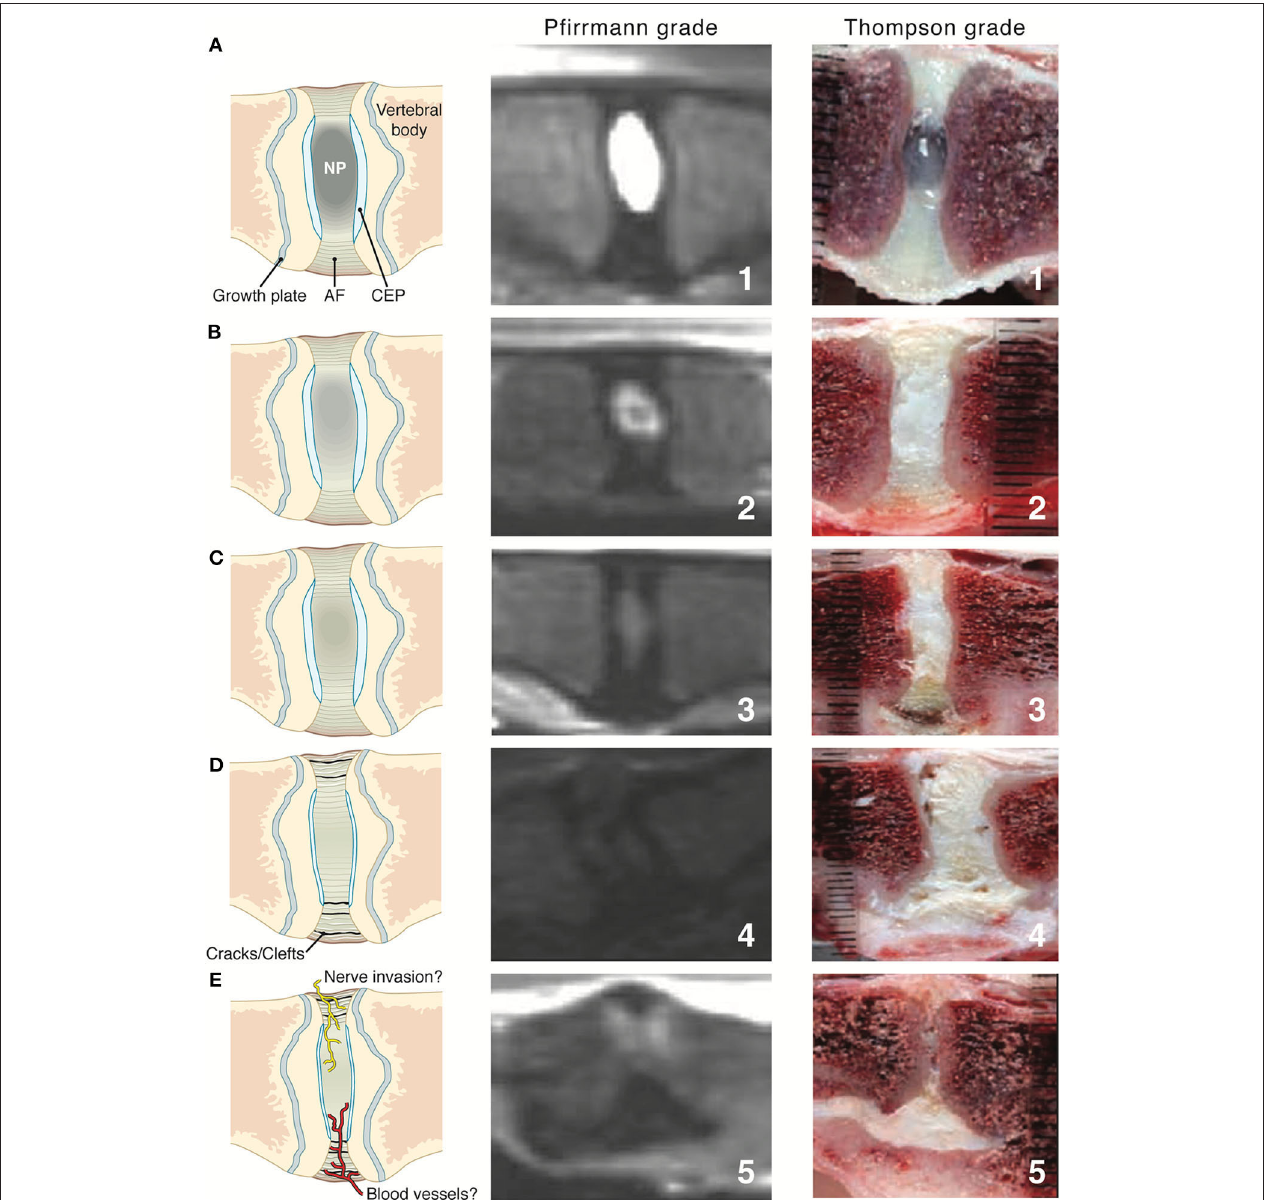
FIGURE 5 | Intervertebral disc (IVD) maturation from young to early and late stage IVDD where the first column shows illustrative representations throughout the stages (A–E) , middle column shows Pfirrmann grading via T2W MR images and last column showing Thompson grading of canine IVD. AF, annulus fibrosus; CEP, cartilaginous end plate; NP, nucleus pulposus. Pfirrmann grade and Thompson grade images adapted with permission from Bergknut et al. (90) and Thompson et al. (91).